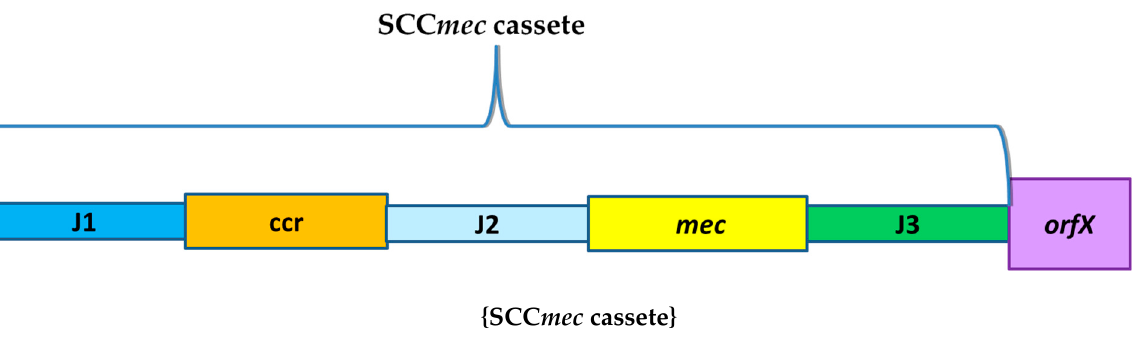
Figure 2. General scheme of SCC mec cassete.